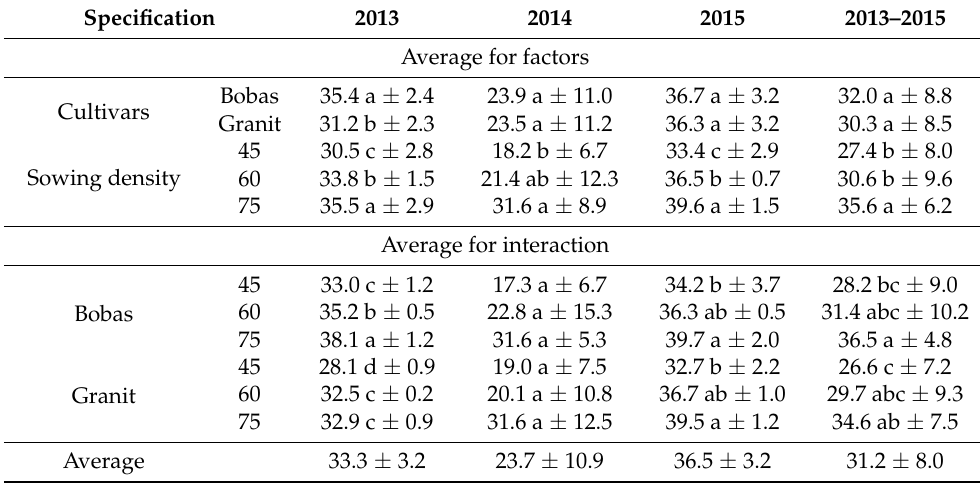
Table 8. Potassium accumulation in the faba bean seeds (kg ha − 1 ) as influenced by the examined factors during the study years